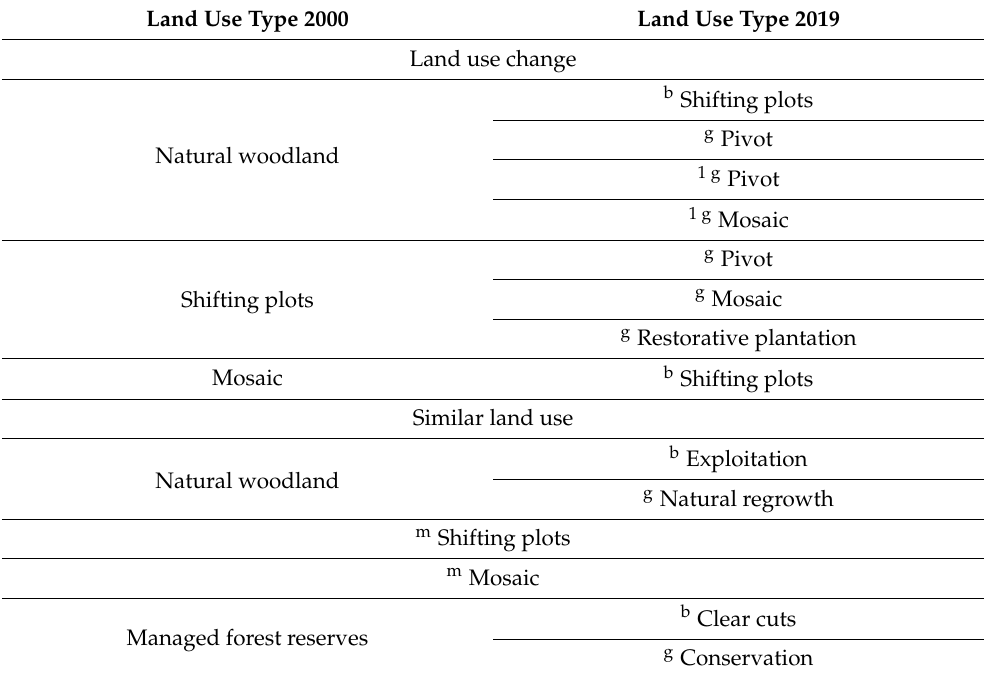
Table 2. Framework for assigning land use processes.